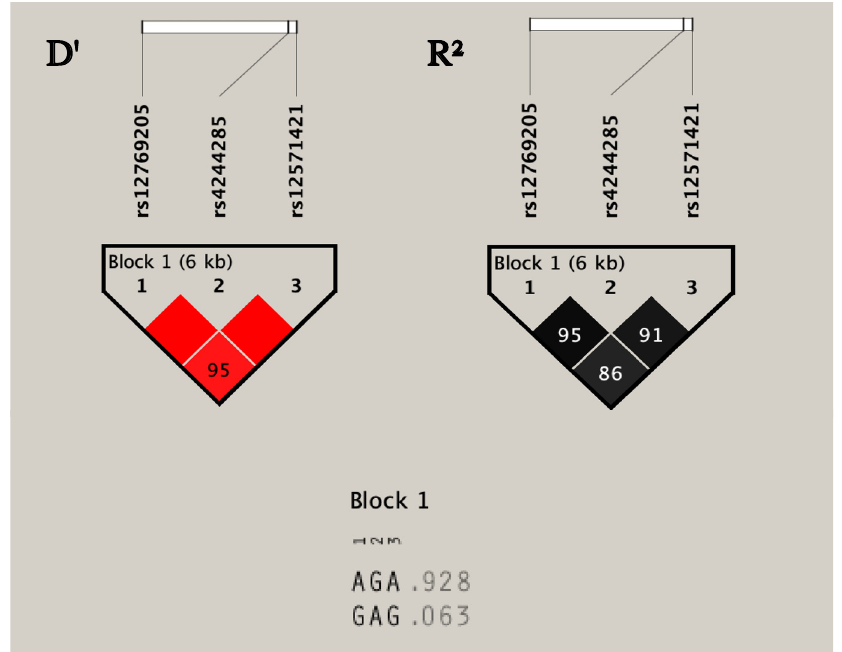
Figure 3. Linkage disequilibrium analysis. Linkage disequilibrium among the intronic single nucleotide variations (SNVs) and haplotype block analyzed by Haploview 4.2 software. The D’ value is shown within the square (D’ = 1, not shown). The three SNVs constitute one haplotype block spanning 6 kb of the CYP2C19 gene. R 2 value indicates the high correlation coefficients between SNVs.